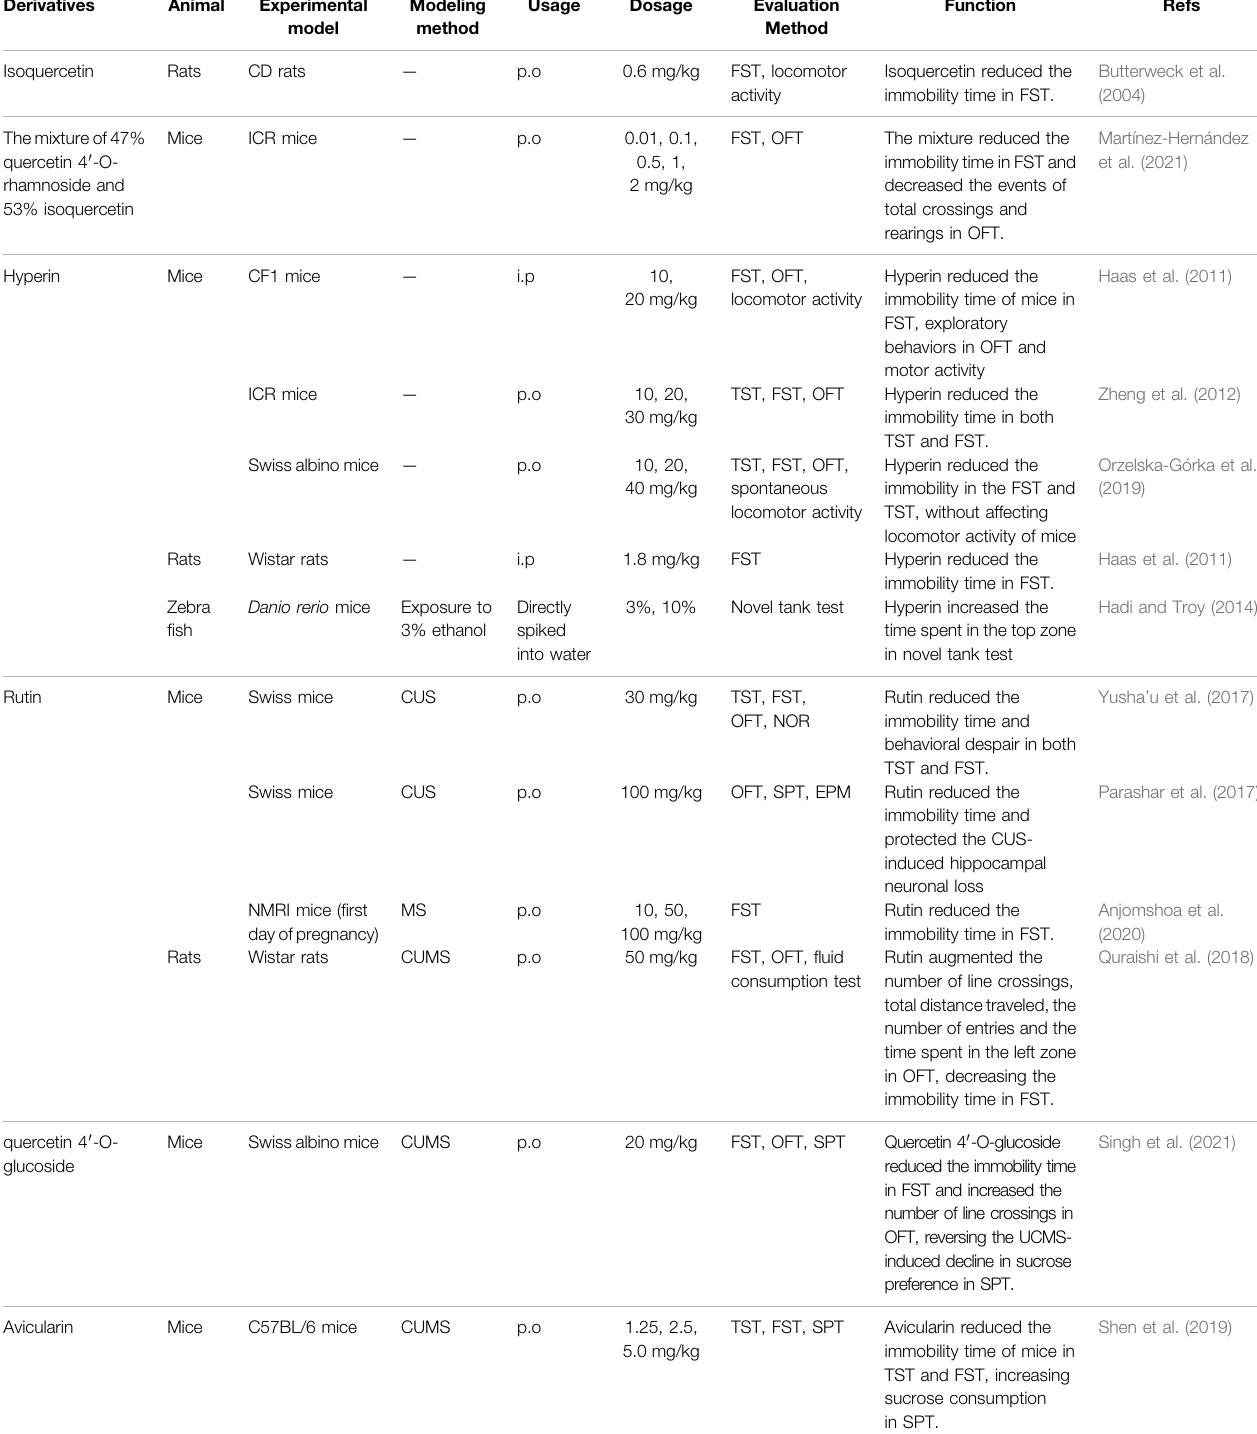
TABLE 2 | The in vivo studies on the antidepressant effects of quercetin glycoside